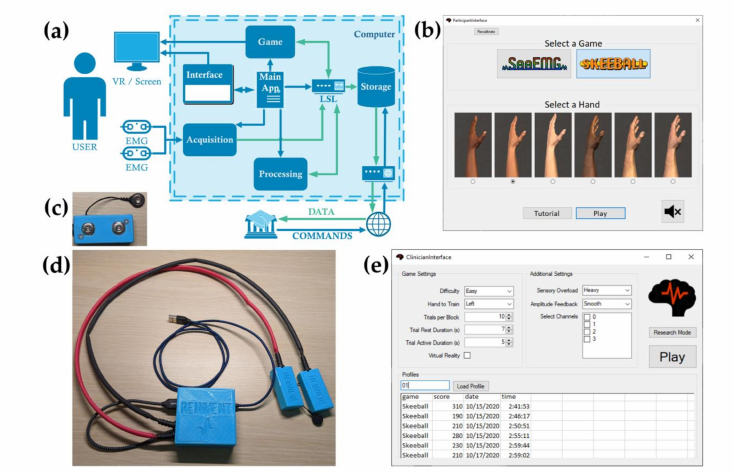
Figure 1. Tele-REINVENT architecture, prototype, and interfaces. ( a ) Software architecture consisting of an acquisition client for electromyography (EMG), signal processing scripts, and a game engine for feedback visualization. Each module is managed by the main application and all data is internally streamed and stored using the Labstreaming Layer (LSL) protocol. This architecture supports both remote data retrieval and updates. Green arrows represent data and blue arrows configurations and commands. ( b ) Participant graphical interface. Here, the participant can select the game to play and set user configurations accordingly. ( c ) Case and Myoware sensor with connectors for disposable EMG electrodes. ( d ) Tele-REINVENT prototype consisting of 2 Myoware EMG sensors, a Teensy 4.0 development board, and a USB isolator enclosed in 3D-printed cases. ( e ) Clinician graphical interface. Here, the clinician can set up configurations for the biofeedback game, such as number of trials, trial duration, and difficulty. Additionally, the interface can show data from previously recorded